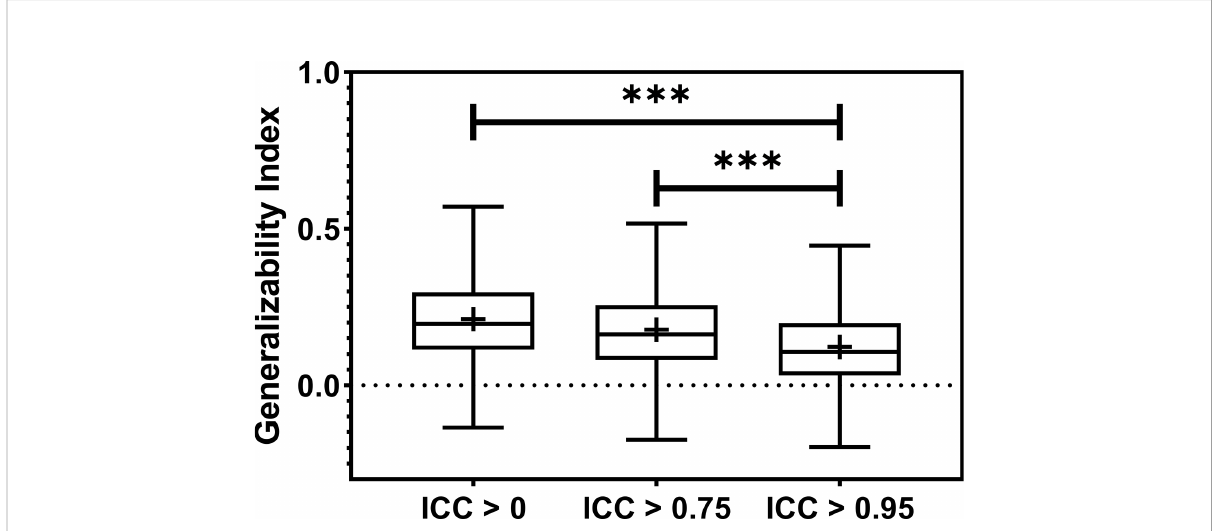
FIGURE 5 The boxplot showed the train-test performance differences. The most restricted feature robustness fi ltering provides the most generalizable models. *** indicates the p-value is smaller than